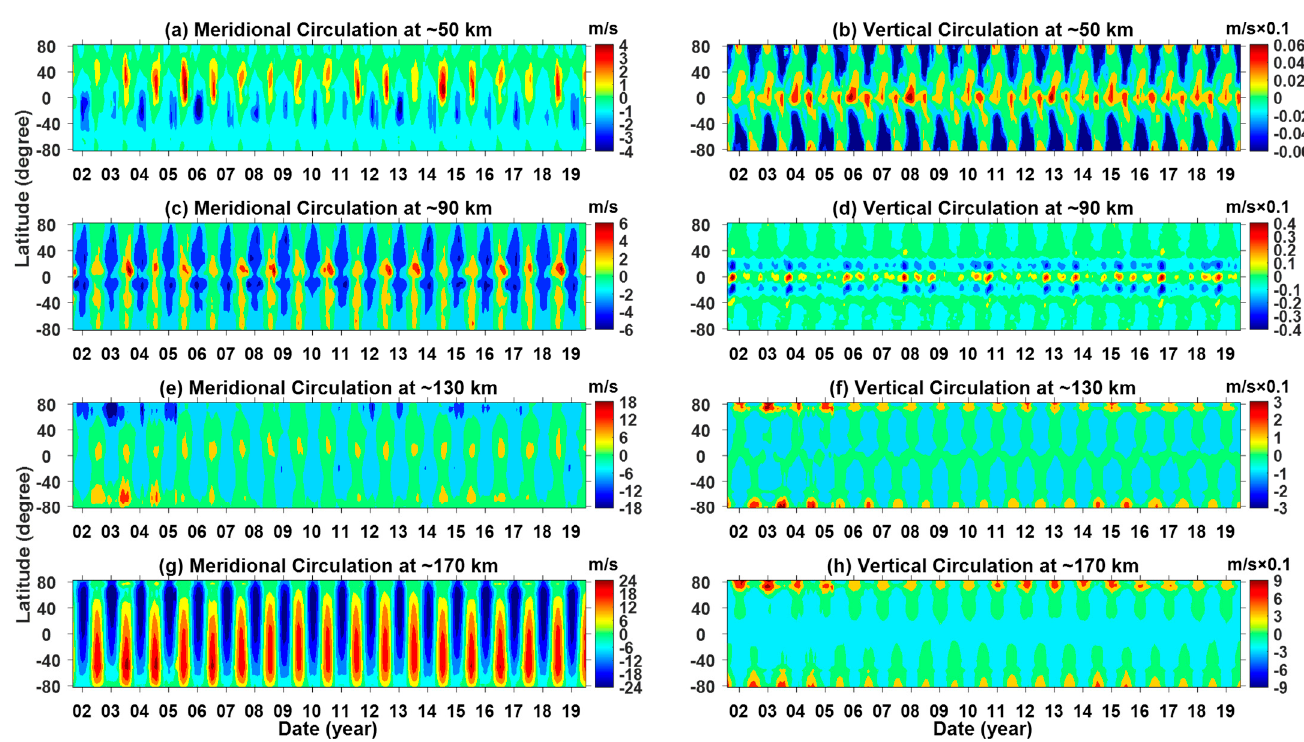
Figure 3. Temporal variations in the ( a , c , e ) meridional circulation and ( b , d , f ) vertical circulation at ( a , b ) ~70° S, ( c , d ) ~40° S, and ( e , f ) ~10° S.